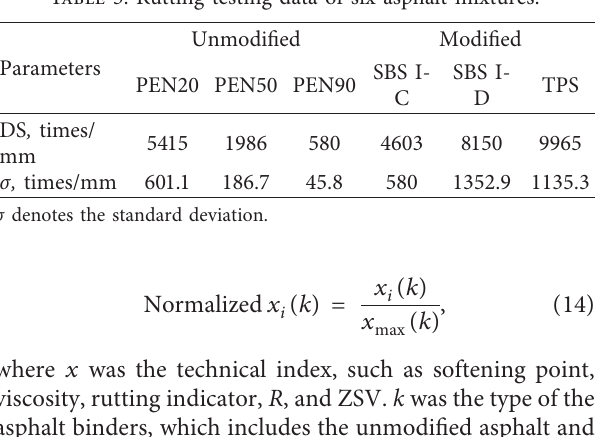
Table 5: Rutting testing data of six asphalt mixtures.